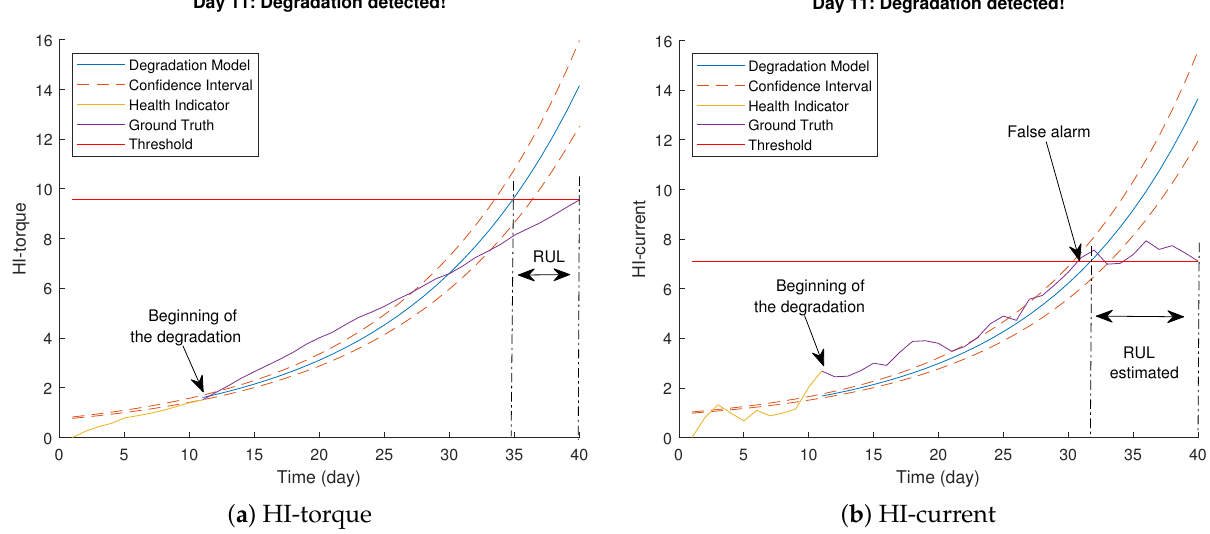
Figure 9. Predicted trajectories of the HI-torque and HI-current using the exponential degradation model.